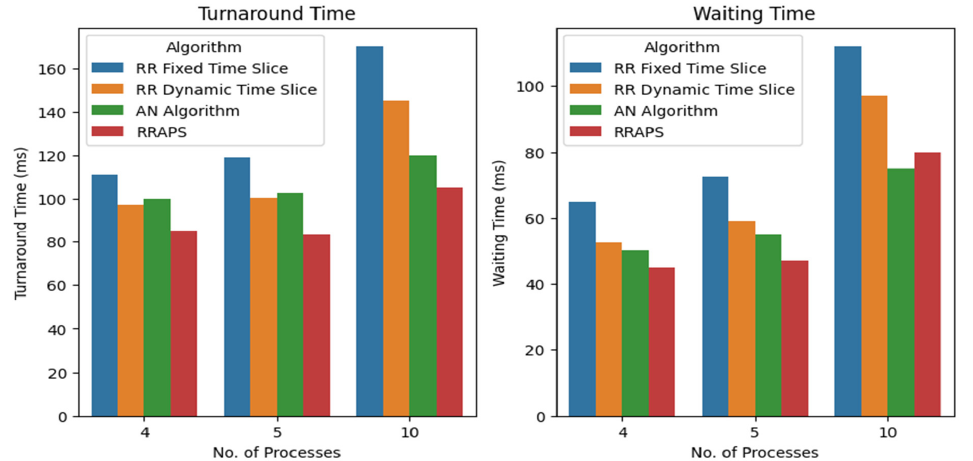
Figure 2. Comparison of turnaround and waiting time for 4, 5, and 10 processes.